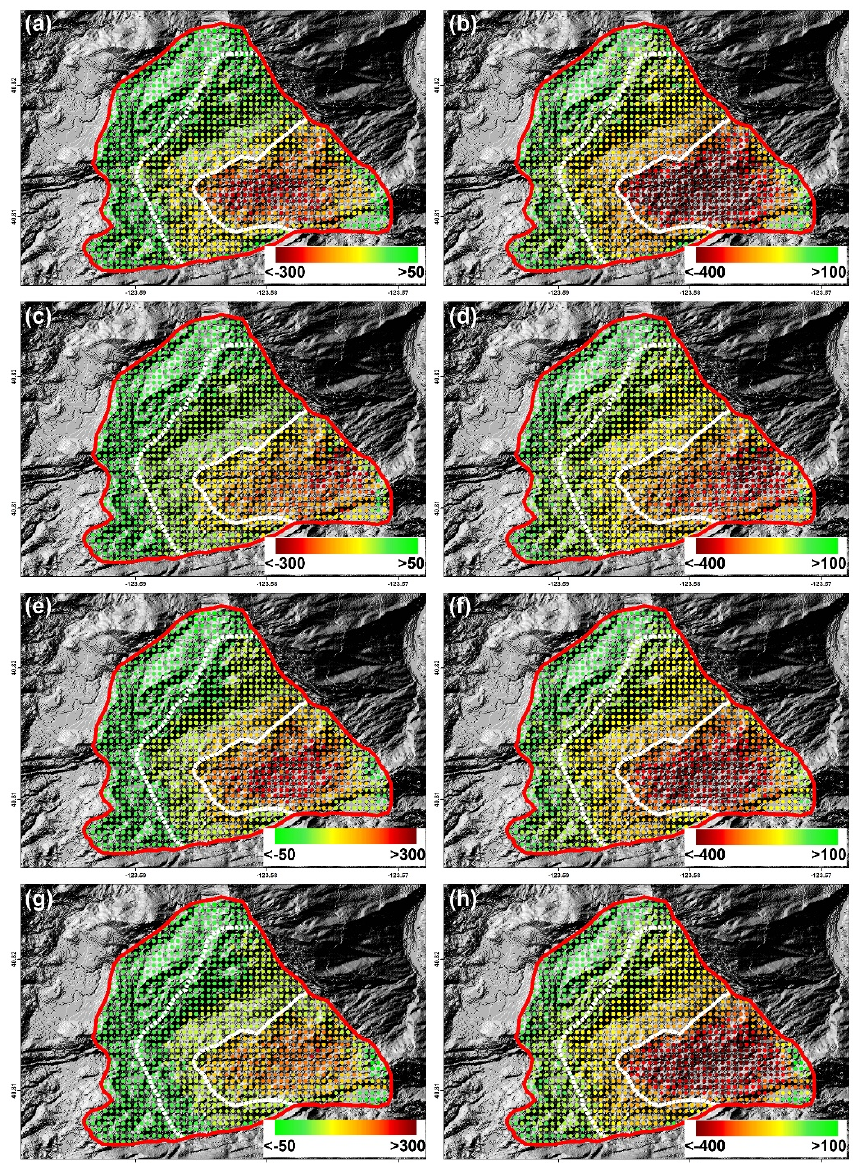
Figure 10. Average annual LOS ( left column) and down-slope ( right column) deformation rates of active landslide extracted from P68 (( a ) and ( b )), P69 (( c ) and ( d )), P170 (( e ) and ( f )) and P171 (( g ) and ( h )) (unit: mm/yr). It is worth noting that the same color legend is used in the right column but a different one in the left column.